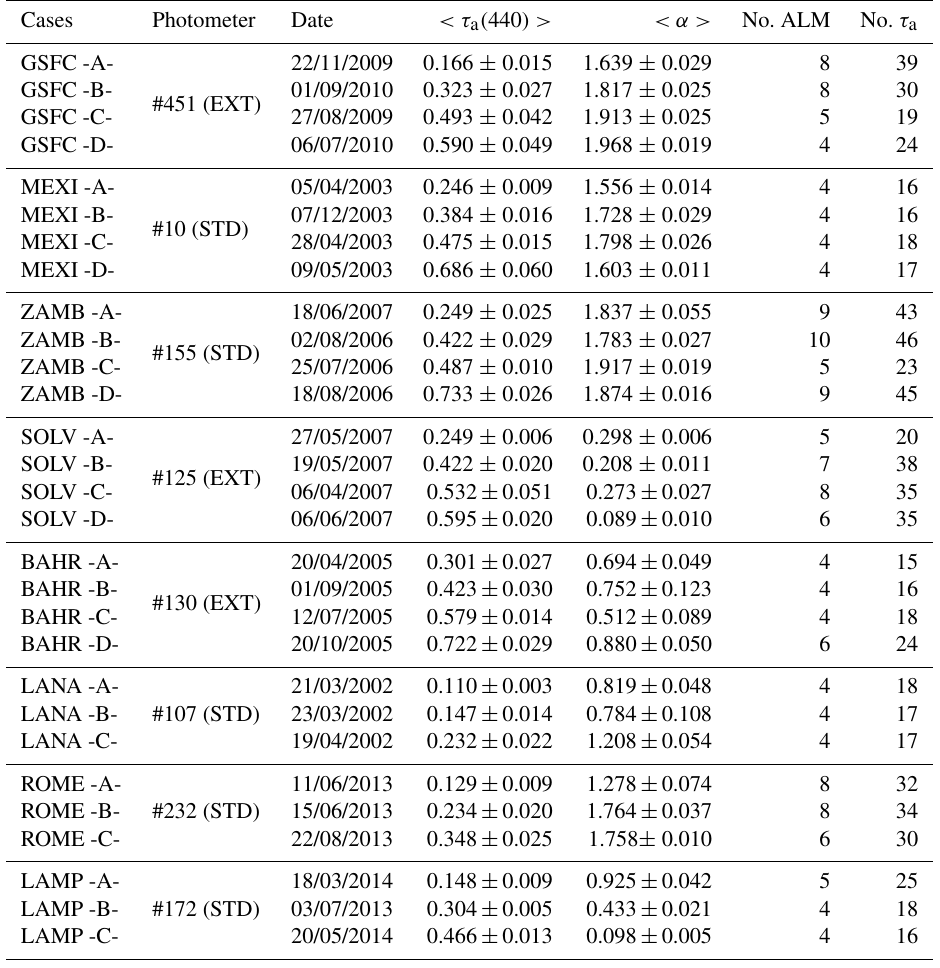
Table 13. Summary of the 29 days chosen for comparison between the new GRASP-AOD inversion and the AERONET products. The first columns depict information about the day selected: site, photometer, date, τ a at 440nm and Ångström exponent. The last two columns contain the number data used for each inversion type: ALM or almucantar used for the AERONET inversion, and τ a used for both the GRASP-AOD inversion and SDA algorithm. STD and EXT refer to the standard and extended version of the Cimel-310 sun photometer respectively (see Table A1). The 340nm channel of photometer #172, at Lampedusa site, was excluded for quality assurance